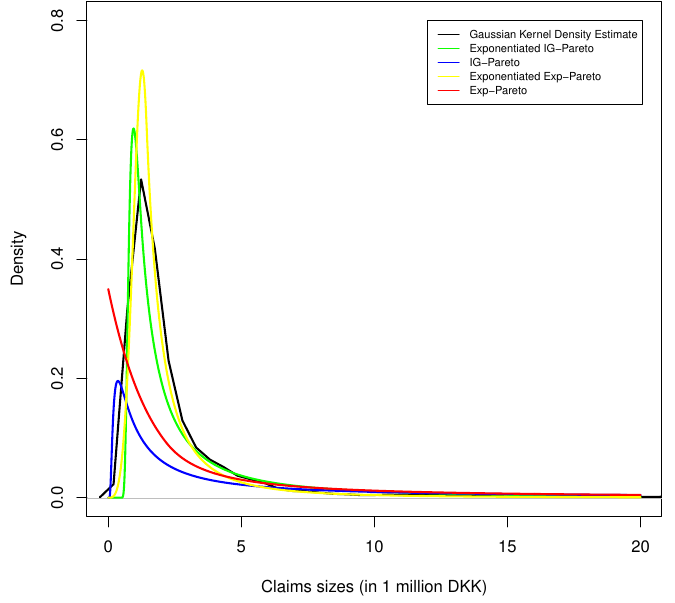
Figure 4. Kernel density estimate of Danish fire insurance data, with corresponding exponentiated exp-Pareto, exp-Pareto, exponentiated IG-Pareto, and IG-Pareto fit.